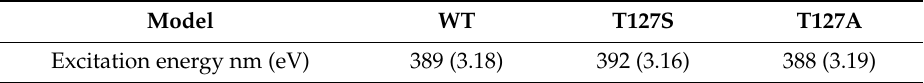
Table 2. Computed excitation energies at the sTD-DFT CAM-B3LYP / cc-pVDZ level of